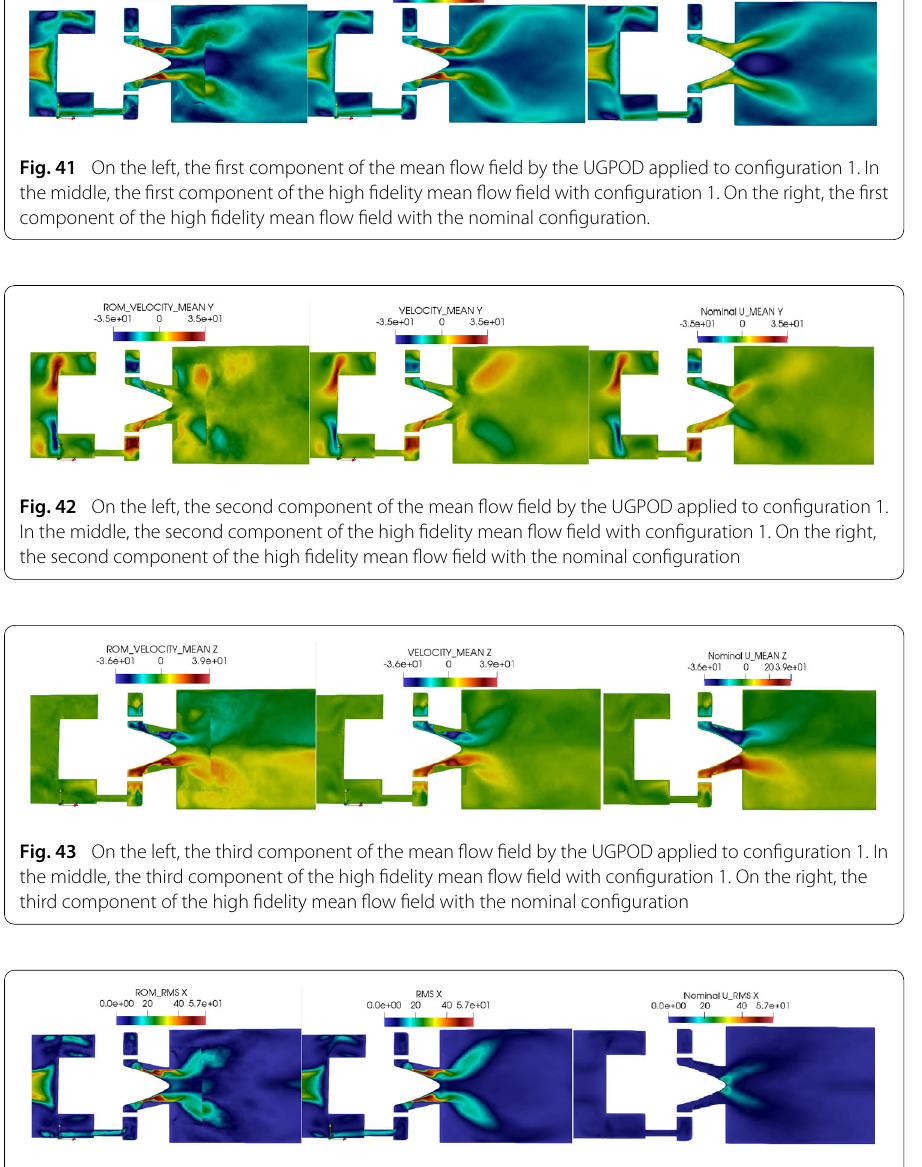
Fig. 44 On the left, the first component of the root mean square flow field by the UGPOD applied to configuration 1. In the middle, the first component of the high fidelity root mean square flow field with configuration 1. On the right, the first component of the high fidelity root mean square flow field with the nominal